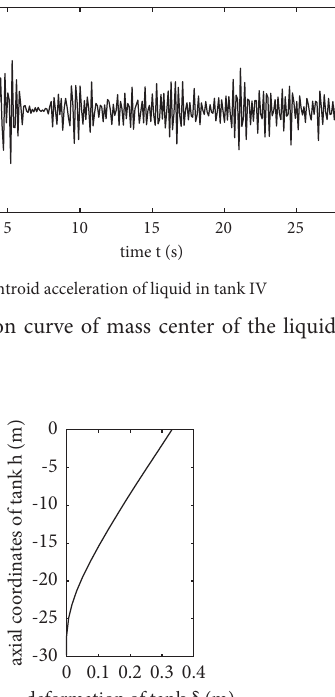
0 0.1 0.2 0.3 Figure 16: Diagram of the combined deformation-axial coordinate (the moment of maximum deformation).